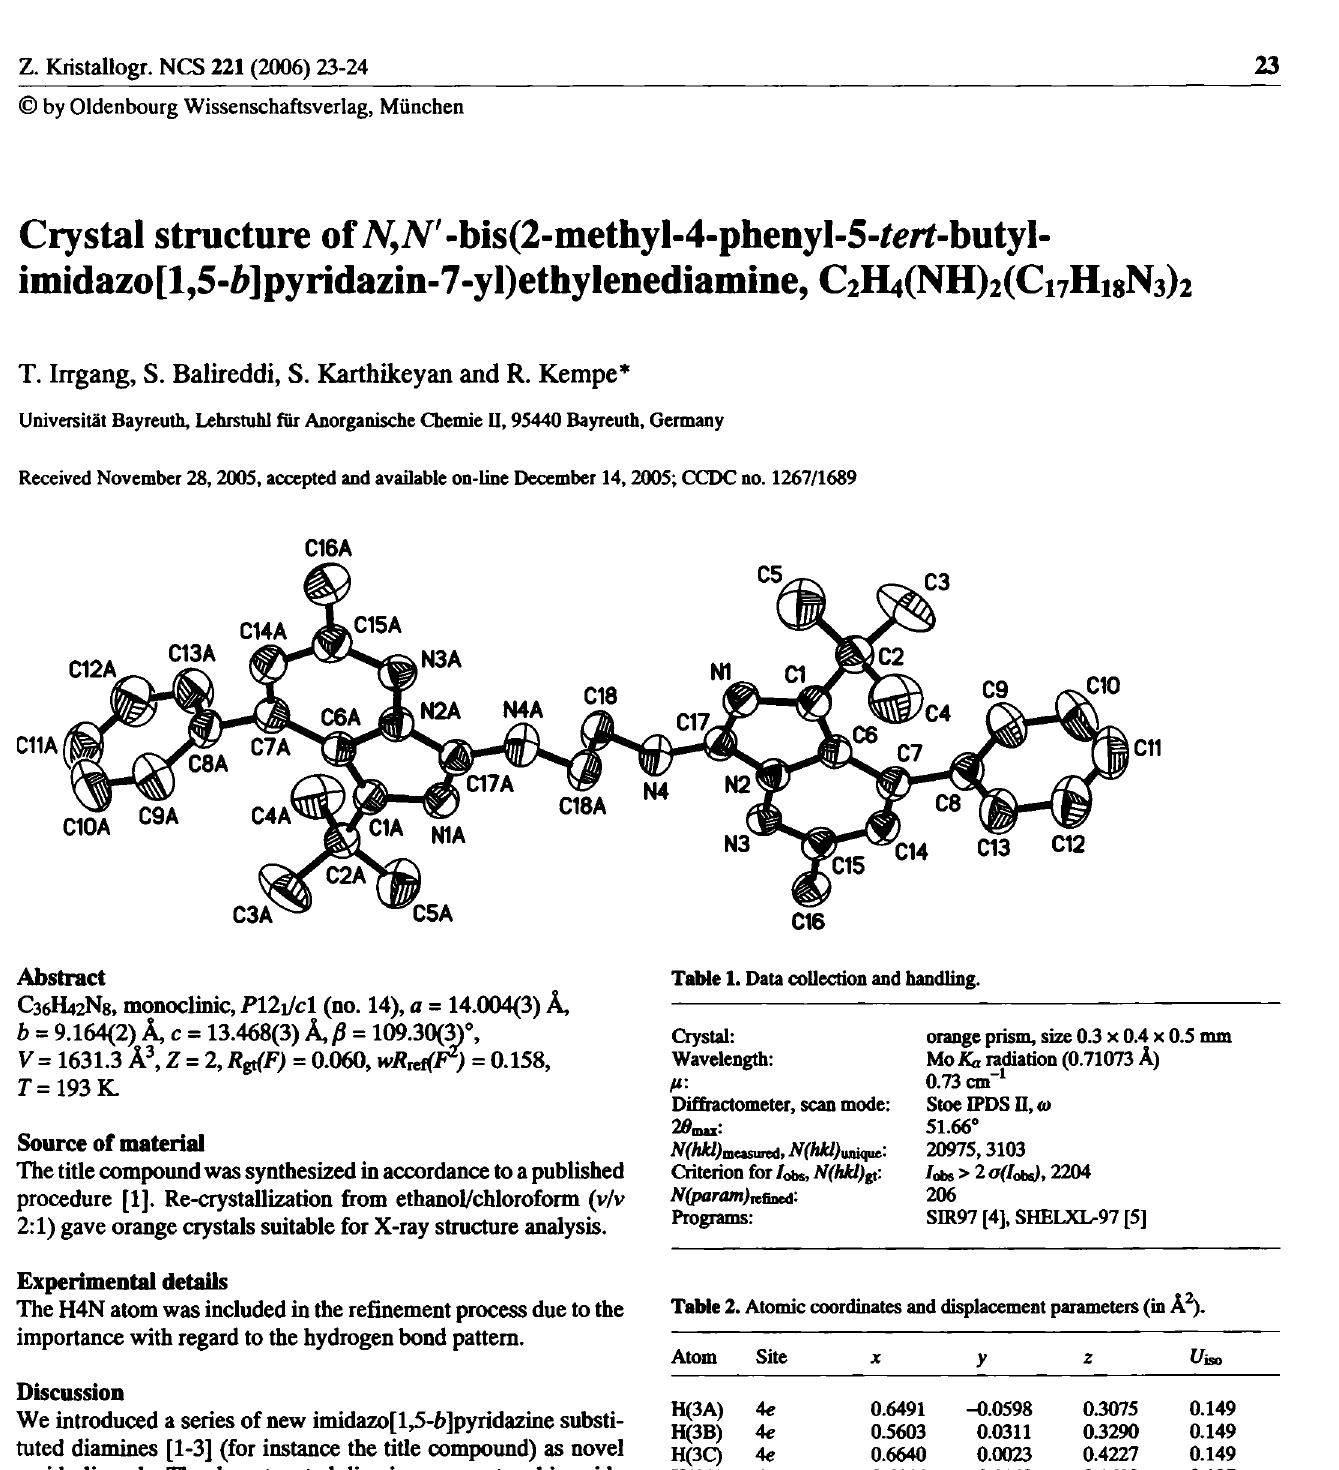
Table 2. Atomic coordinates and displacement parameters (in Ä 2